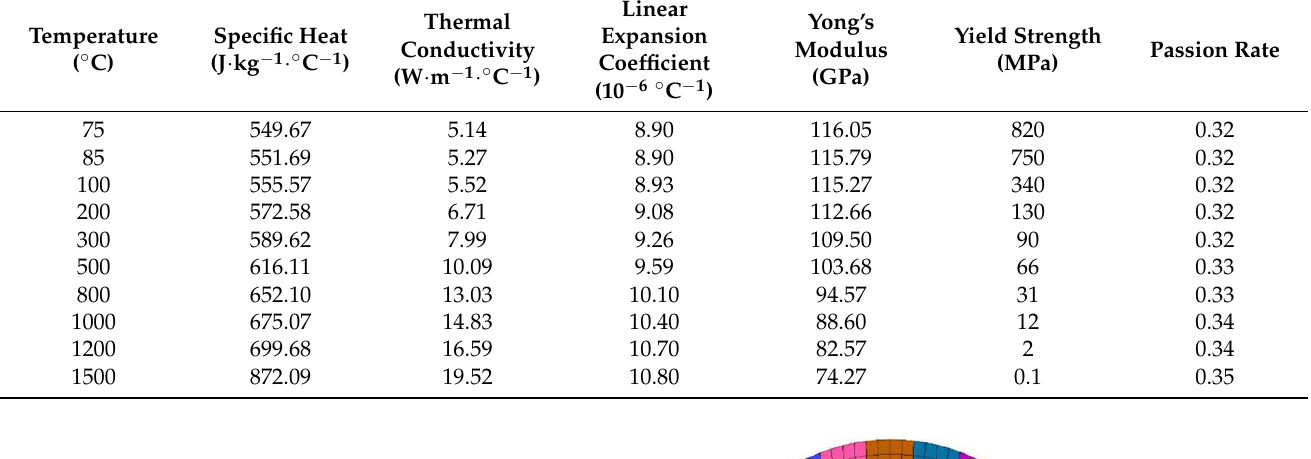
Figure 5. Dimension for the tensile test.